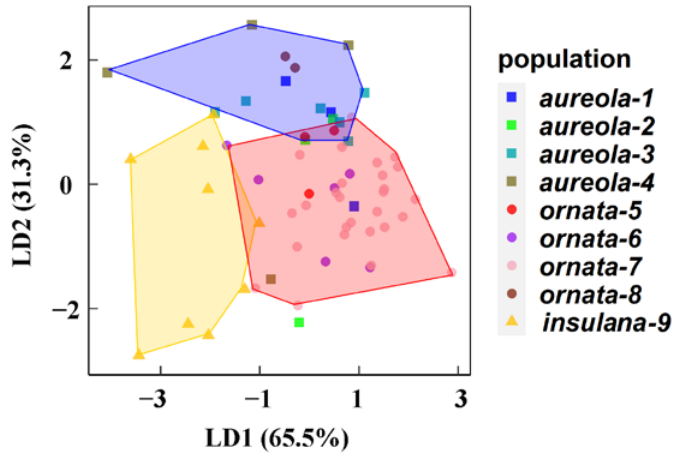
Figure 5. LDA indicated that the nine populations could be separated completely by the first two discriminant functions.